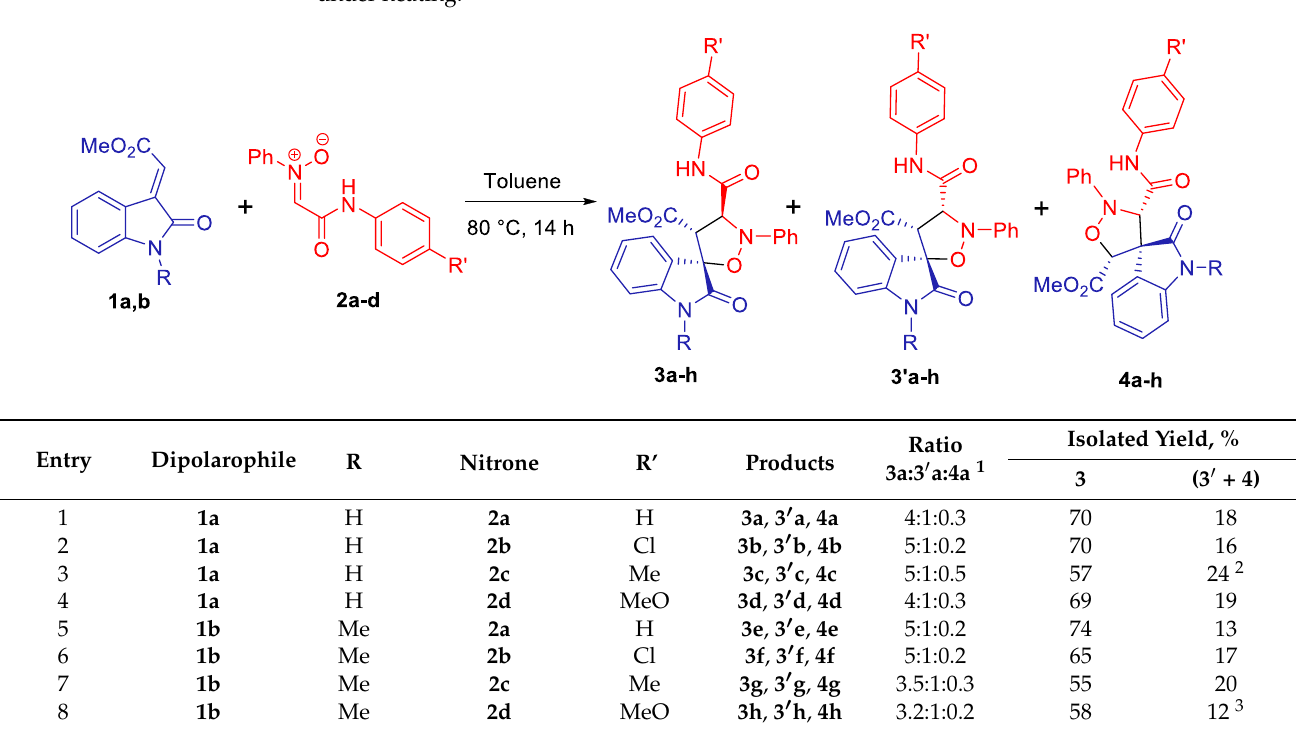
Table 2. Cycloaddition of 2-(2-oxoindoline-3-ylidene)acetates 1a,b with C -carbamoyl nitrones 2a-d under heating.